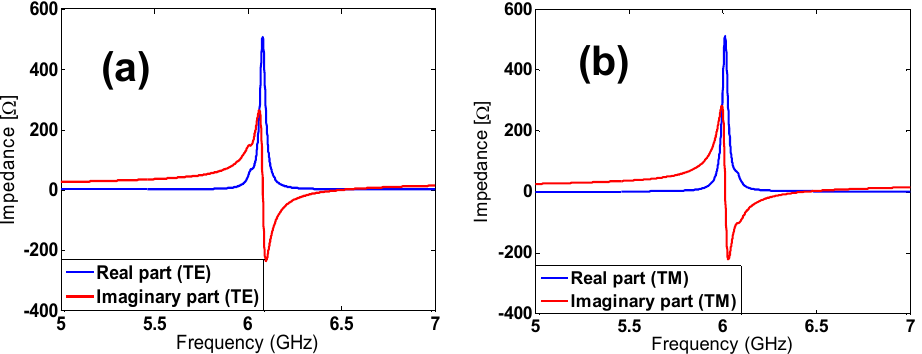
Figure 13. Real and imaginary part of the impedance for both the ( a ) TE configuration and ( b ) TM configuration, under normal